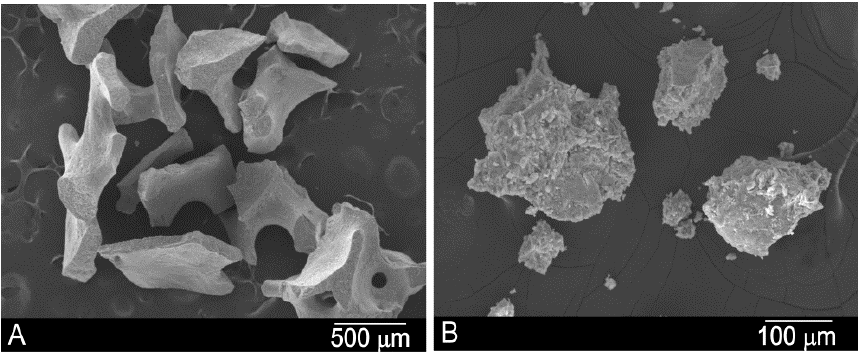
Figure 1. Scanning electron micrographs of ( A ) the BBM and ( B ) PBM xenograft materials before implantation. Table 1. Physical properties of the two xenograft materials [33].